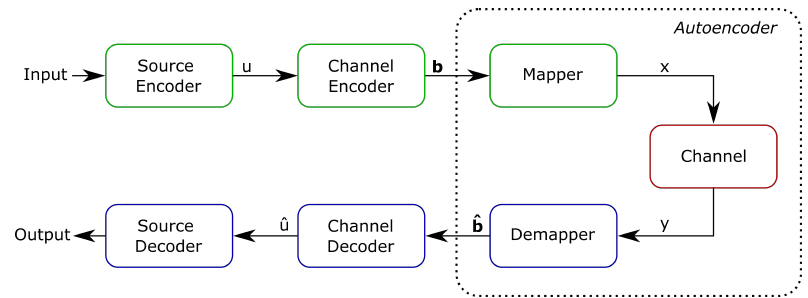
Figure 1. Digital communication